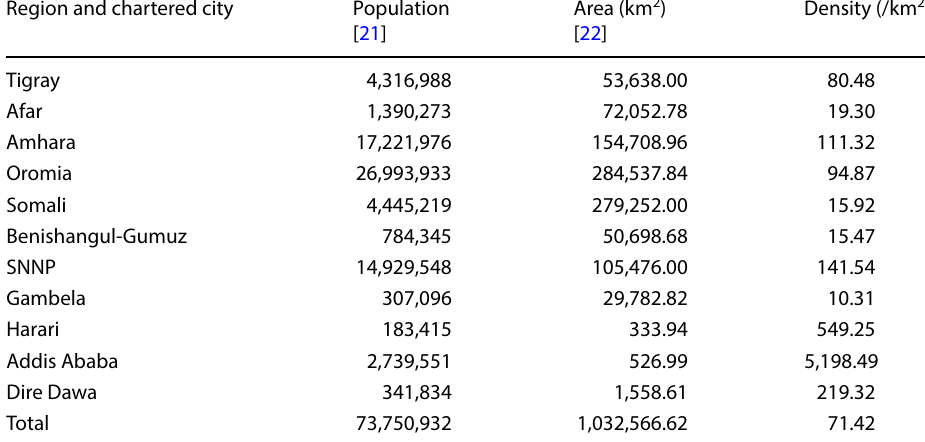
Table 1 Population density in Ethiopia. Source: CSA [21,